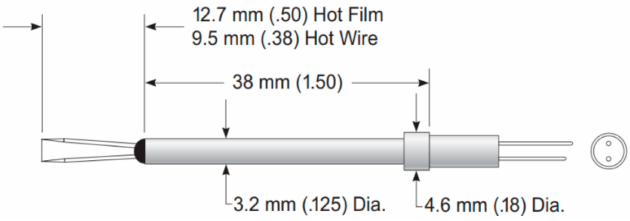
Figure 7. Specification of I-type hot wire